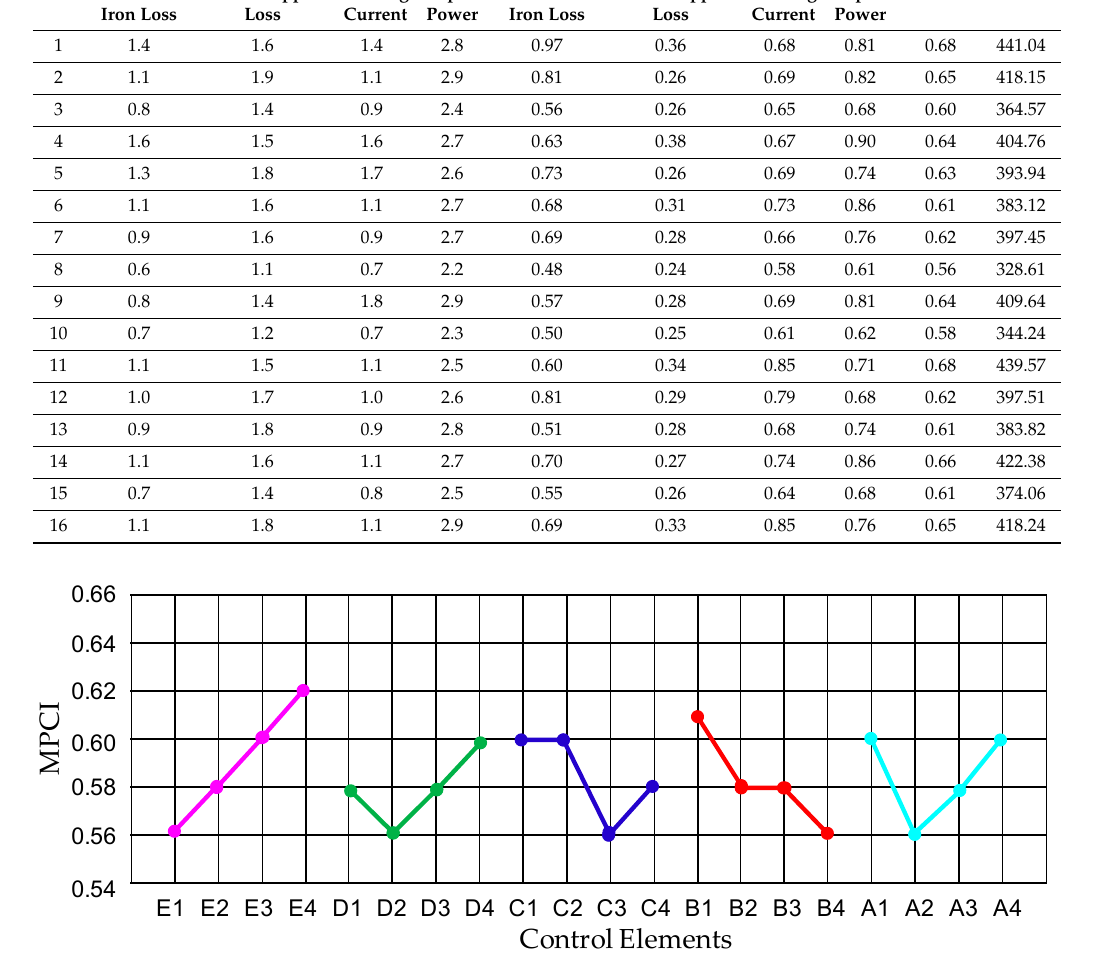
Figure 3. The MPCI values for each element with corresponding levels in the first-phase design.